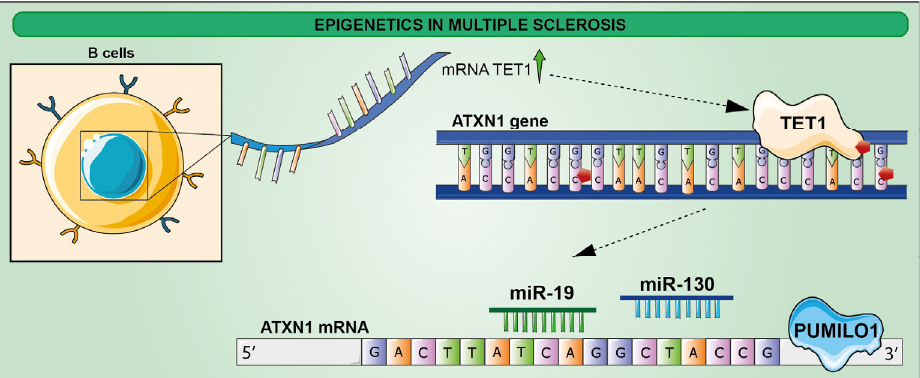
Figure 5. Schematic representation of epigenetic modifications in B cells at the clinical onset of MS. ATXN1 gene is hypomethylated in four sites by TET1, of which mRNA is upregulated. PUM1, with miR-19 and miR-130, stabilizes ATXN1 mRNA, leading to the increase in ATXN1 protein levels.